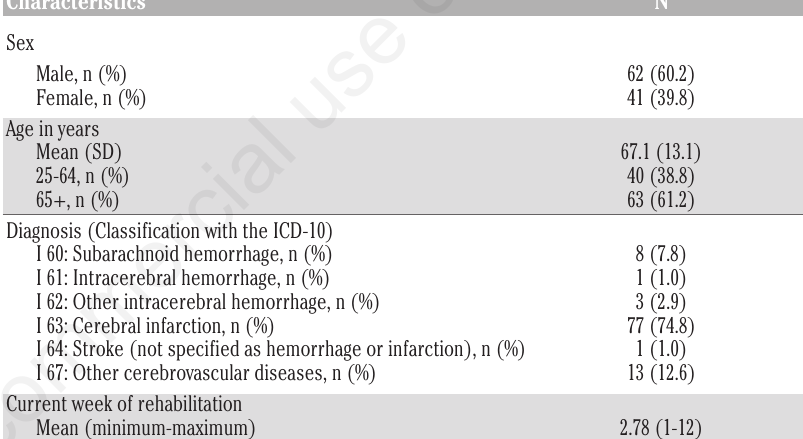
Figure 1. Flow diagram of participants. Table 2. Main characteristics of the respondents